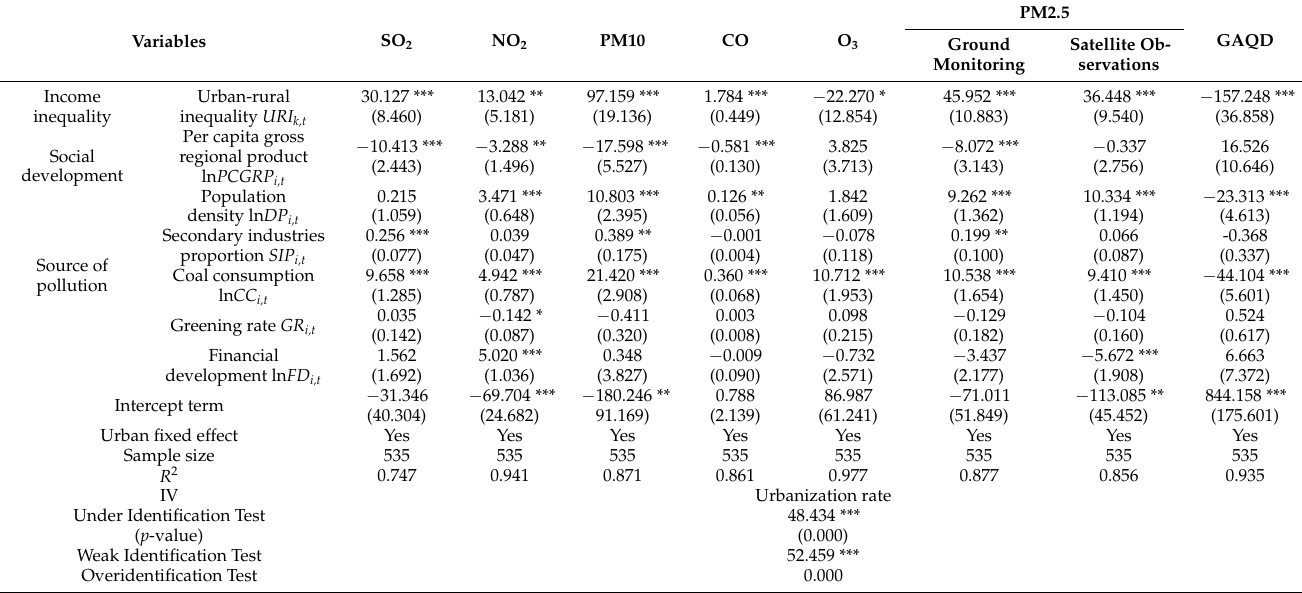
Table 5. TSLS regressions analysis for air pollution and income inequality.